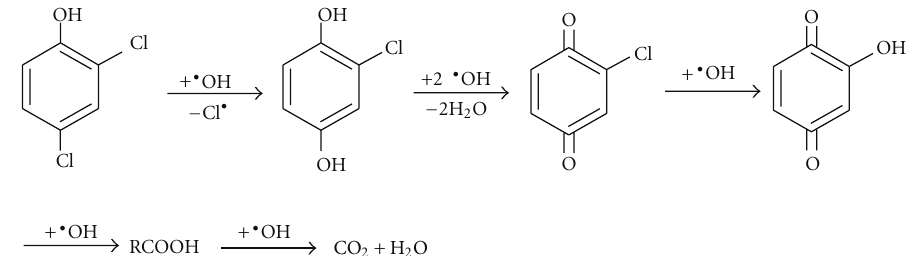
Figure 9: Photocatalytic degradation scheme for DCP